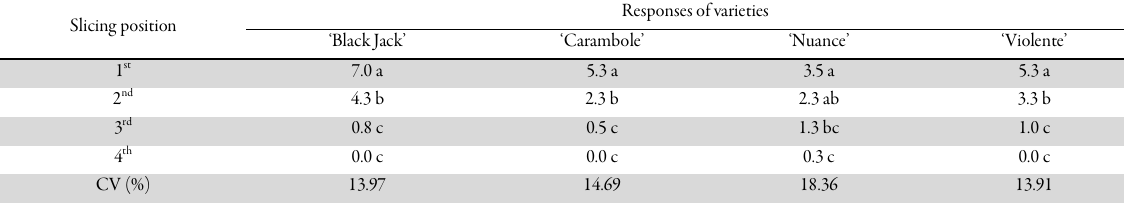
Table 3. Interaction effect of slicing positions and responses of varieties on number of shoots per explant Slicing position